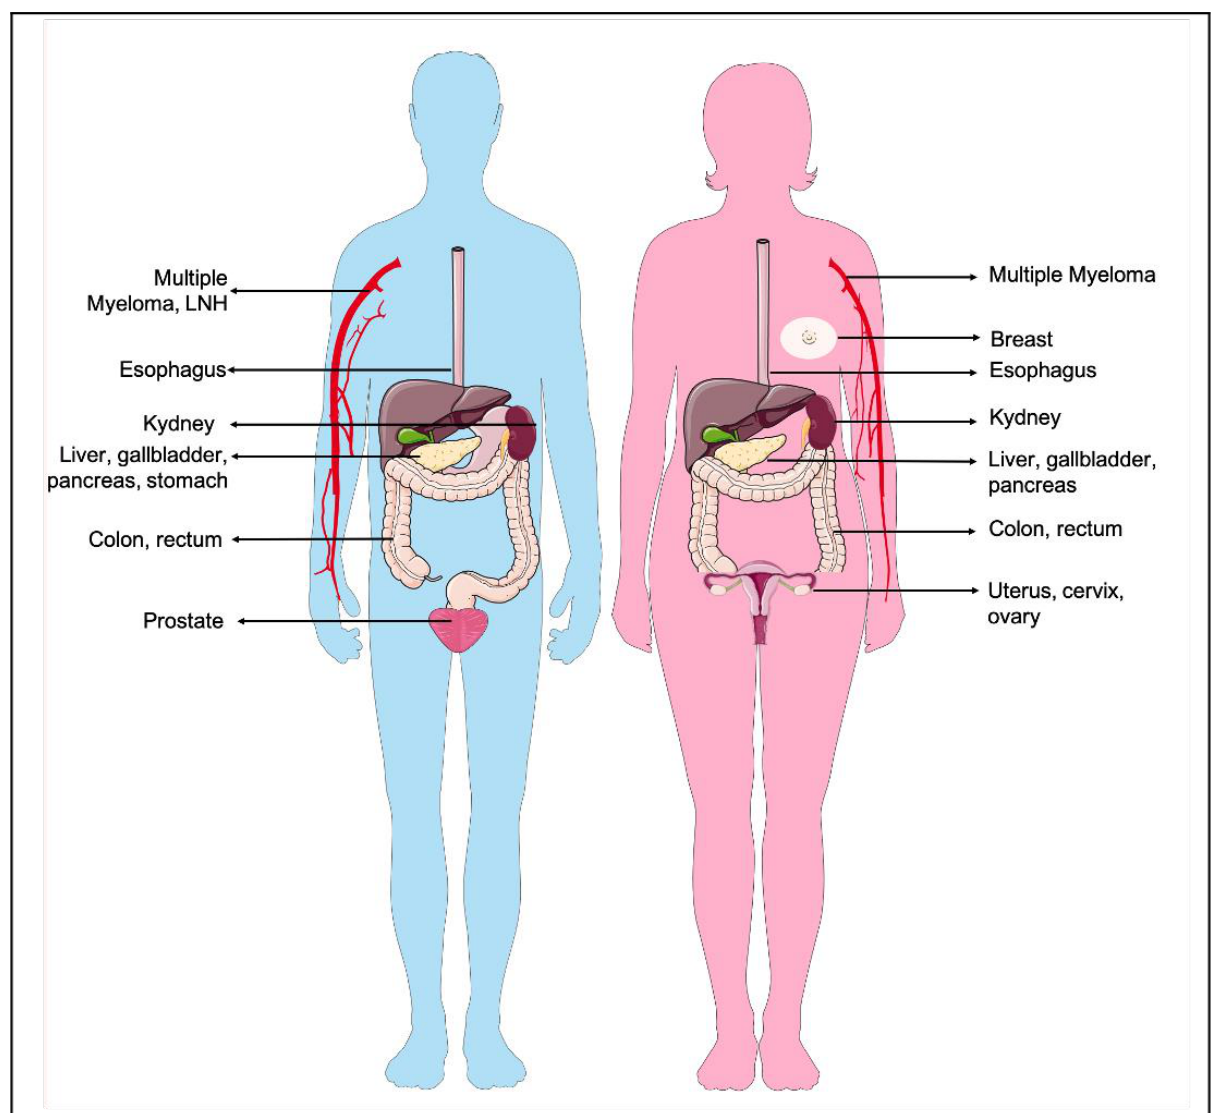
Figure 1. Overweight and obesity increased the risk for developing cancer in different sites. Body fat has been associated with increased risks for a number of cancers that occur in different sites according to sex. The cancer types depicted in the figure displayed increased mortality rate if in association with an obesity condition. Parts of the figure were drawn by using pictures from Servier Medical Art. Servier Medical Art by Servier is licensed under a Creative Commons Attribution 3.0 Unported License.